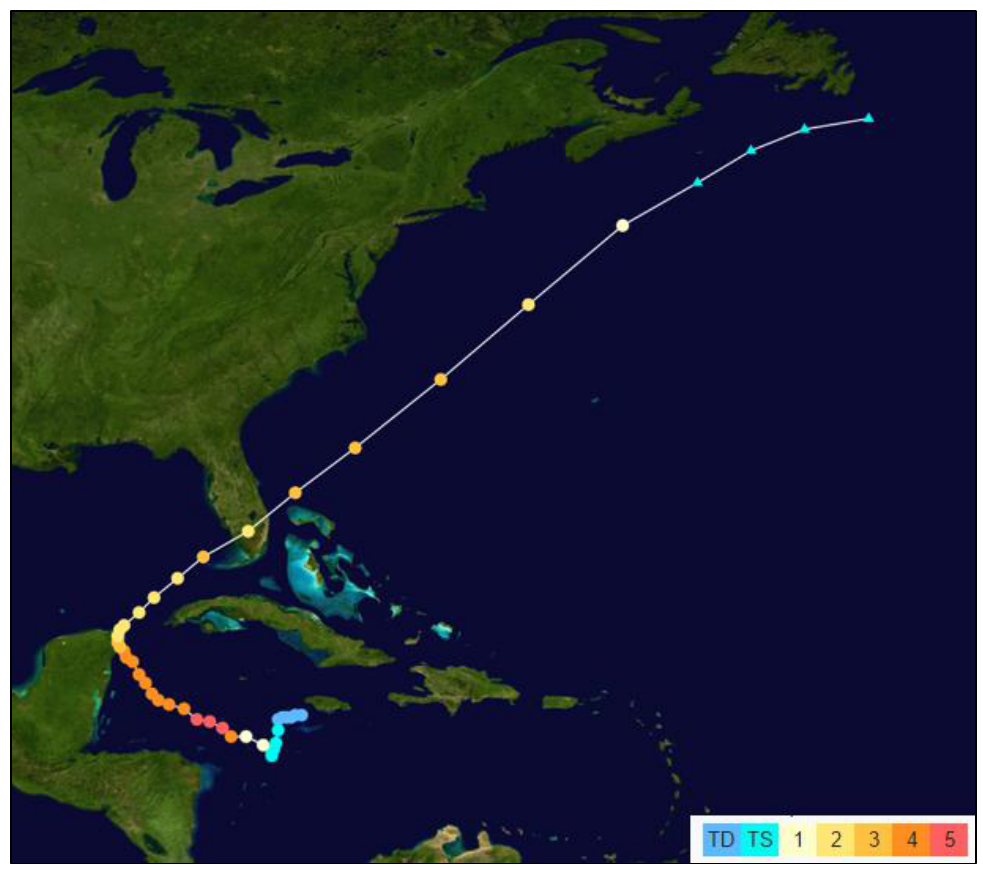
Figure 15. Track of Hurricane Wilma (2005).